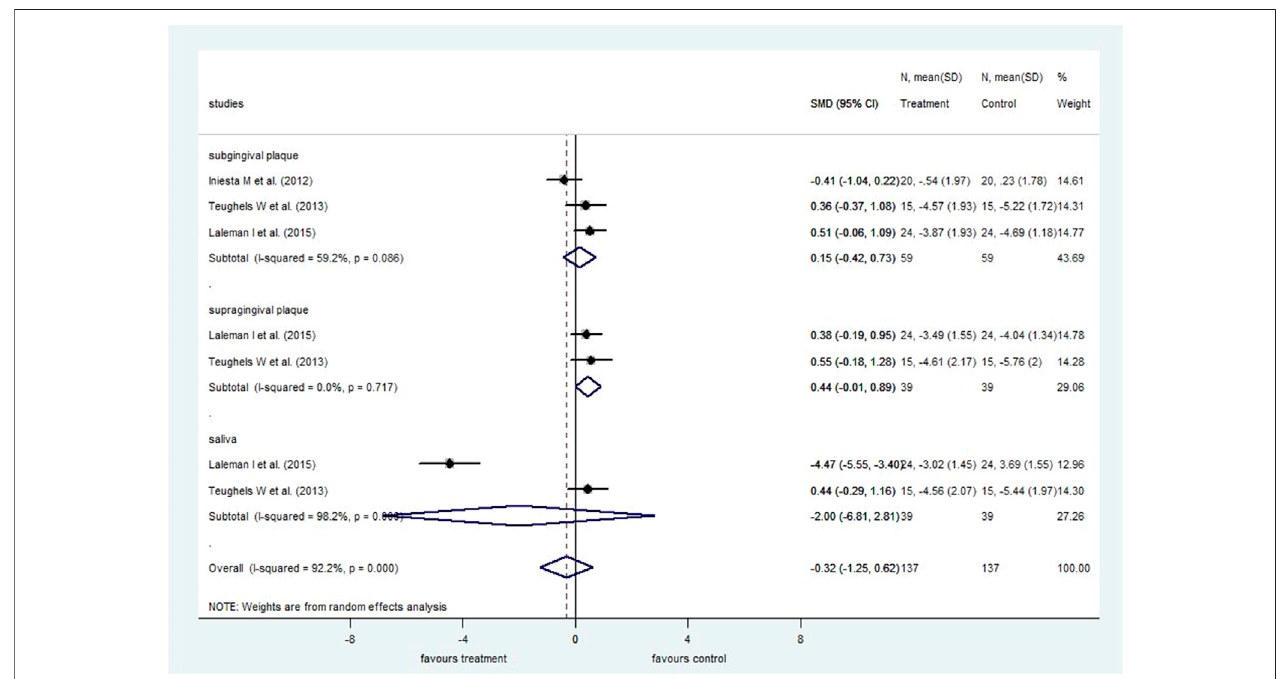
FIGURE 8 | Forest plot analysis of the change in Tannerella forsythia at 4 weeks. The overall result presented no signi fi cant difference of bacterial decrease when both treatment and control groups were compared (SMD: − 0.32; 95% CI: − 1.25 – 0.62).